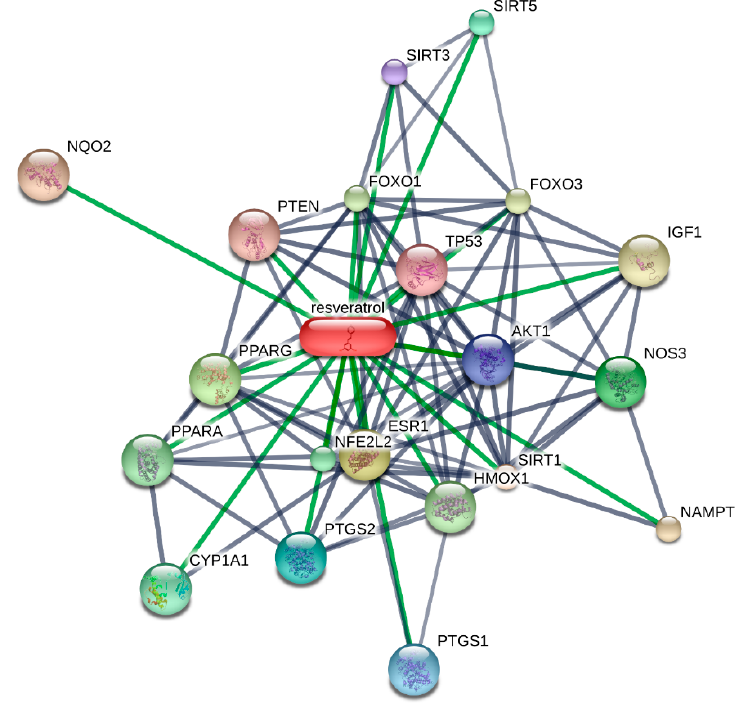
Figure 1. Molecular targets of resveratrol retrieved through the STITCH 5.0 database. Note: SIRT1—